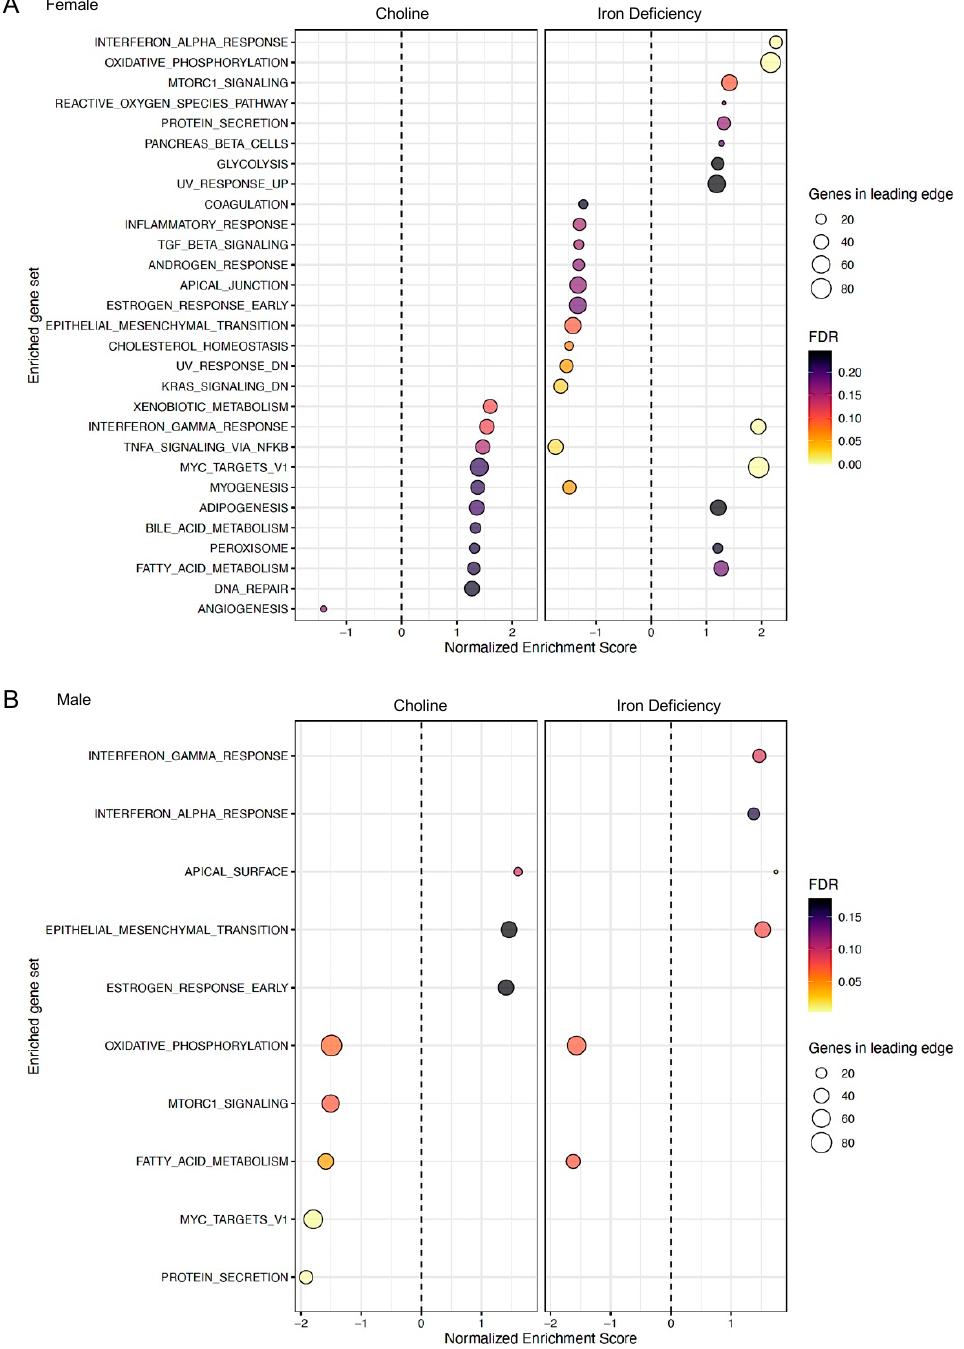
Figure 6. An alternative approach using ranked gene lists. GSEA plots showing the effects of choline supplementation and ID on enriched gene sets of female ( A ), and male ( B ) rats.